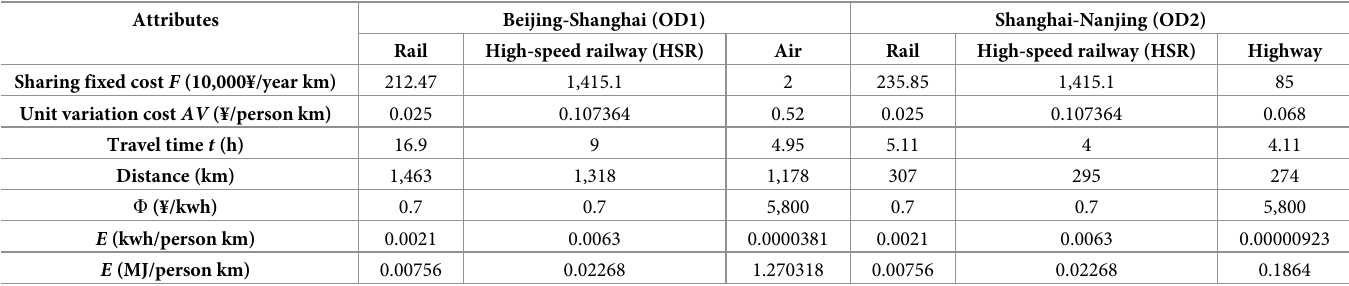
Table 2. Parameter settings for the Beijing-Shanghai corridor.